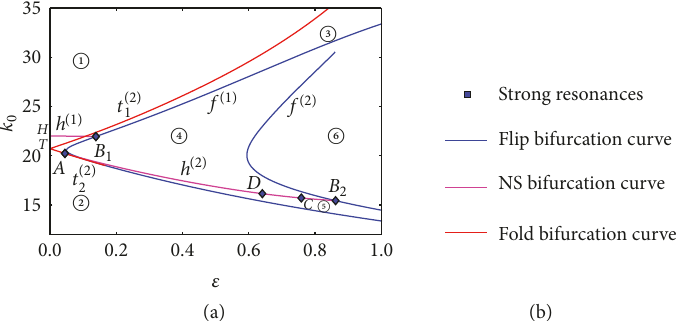
Figure 5: Bifurcation diagrams of system (28a), (28b), (28c), (28d), and (28e) for 𝑎 = 4, 𝑏 = 15, 𝑉 𝑝𝑙 = 2 . (b) Meanings of the symbol and